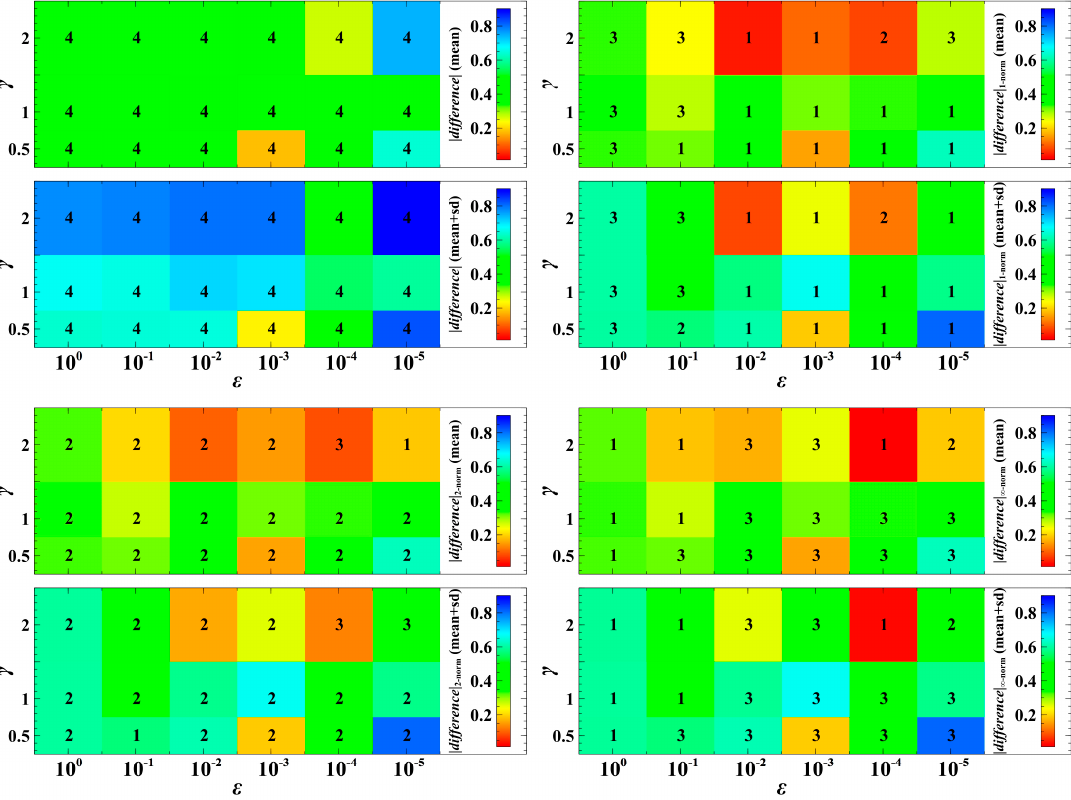
Figure 4. Absolute difference between the population densities of host species 1 and 2. If the difference is near zero, it means that the competition system is egalitarian. The numerals 1 to 4 represent the ranking of the degree of egalitarianism, where 1 denotes the most egalitarian while 4 denotes the least egalitarian. We took the mean and the mean plus standard deviation (sd) of 1000 numerical simulations with random population initial conditions.